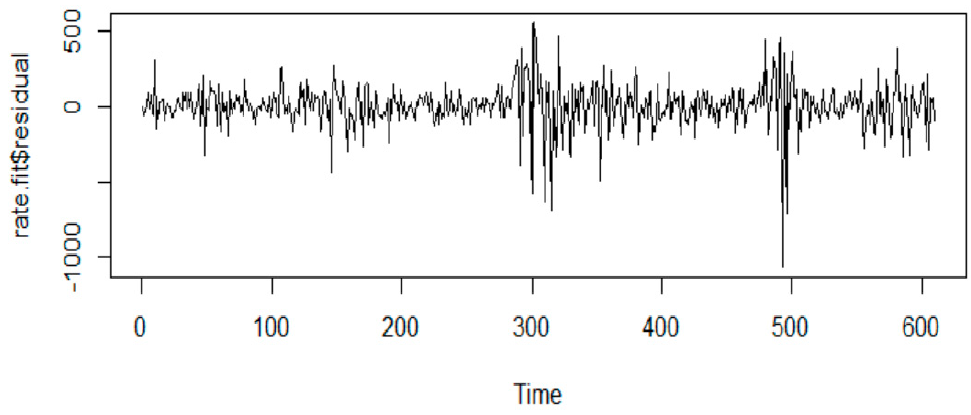
Figure 11. ARCH(2) model’s residual of the Shanghai Index’s daily revenue.